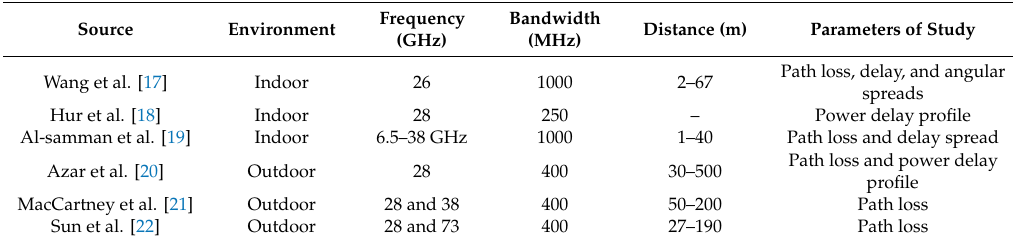
Table 1. Overview of some outdoor and indoor studies at millimeter wave